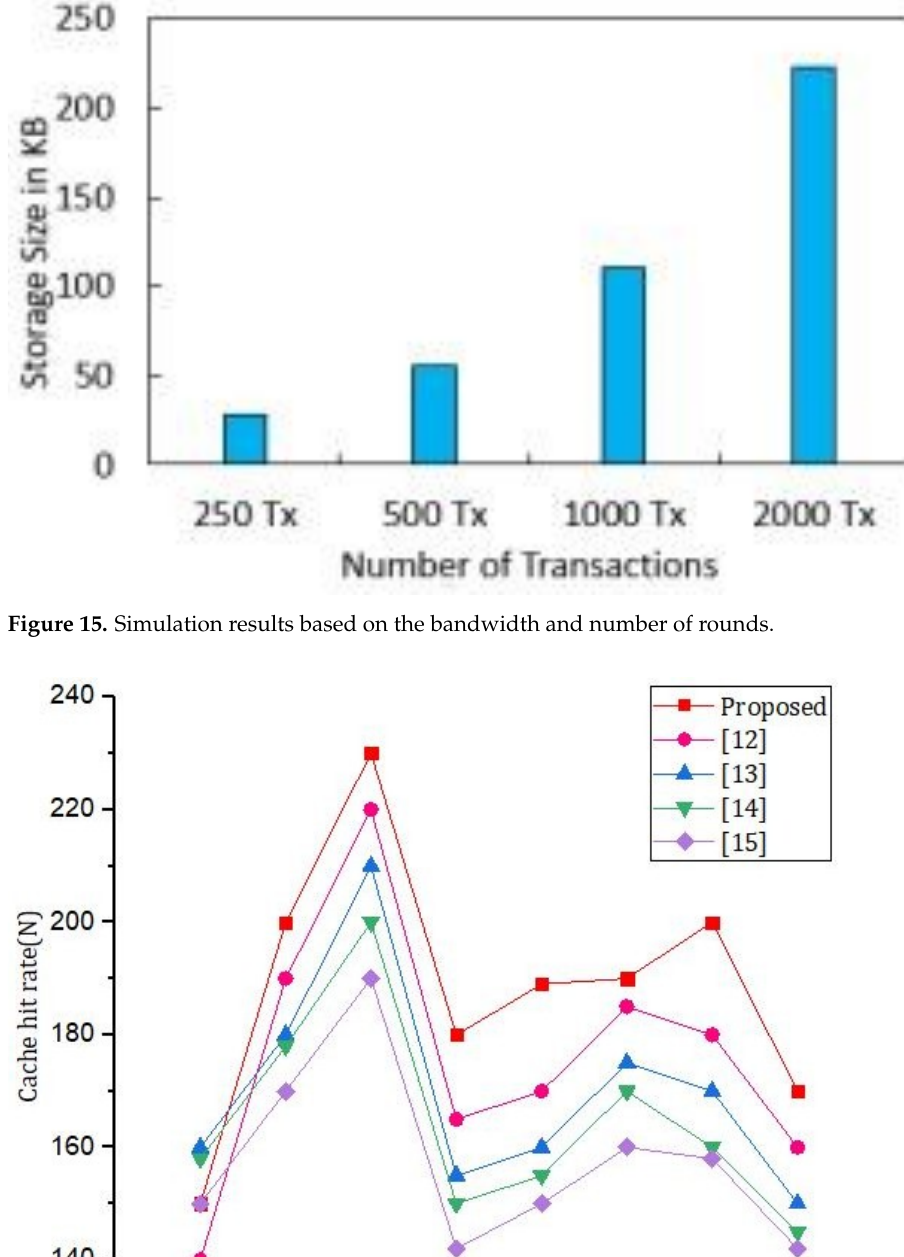
Figure 15. Simulation results based on the bandwidth and number of rounds.